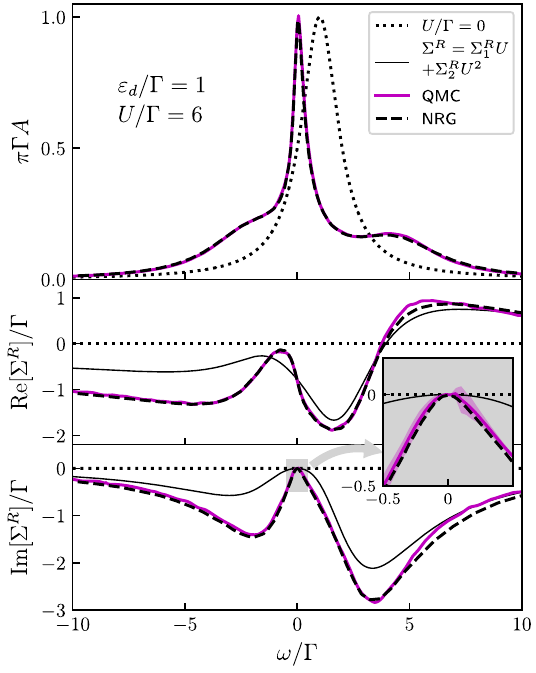
FIG. 10. Resummed equilibrium spectral function (top), real part (middle), and imaginary part (bottom) of the retarded self- energy Σ R ð ω Þ for the symmetric Anderson impurity ϵ U ¼ 9 Γ . Purple line: Resummed result from 10 orders of perturbation theory; dashed line: NRG; dotted line: noninteract- ing result; thin black line: second-order perturbation theory for the self-energy. Inset: Enlargement of the imaginary part at a small energy with error bars.